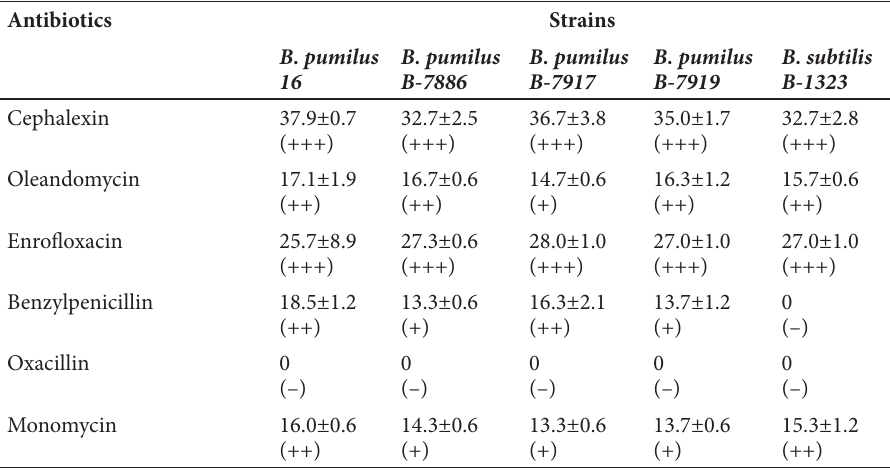
Table 2. Antibiotic resistance (mm (x ± SD) of a novel and type strains Antibiotics Strains